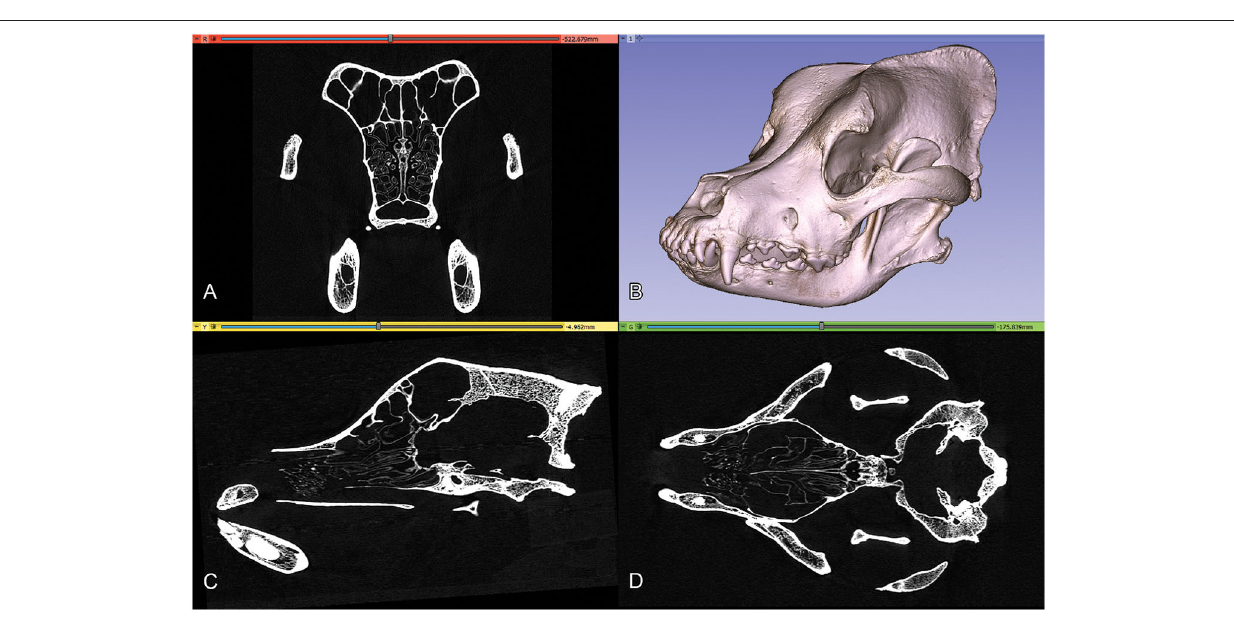
FIGURE 2 | Orthogonal views and volume-rendered model of a Saint Bernard skull’s CT series. (A) Transverse view. (B) 3D volume-rendered image, left rostro-lateral view. (C) Sagittal view. (D) Dorsal